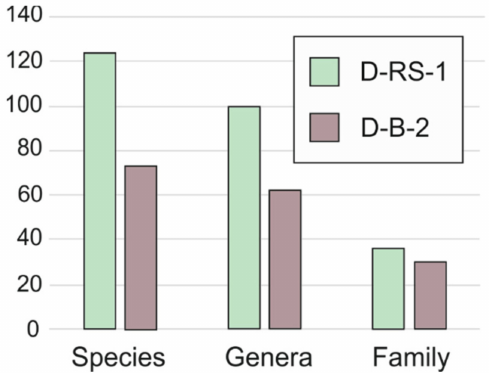
Figure 6. The number of species, genera, and families in the analyzed